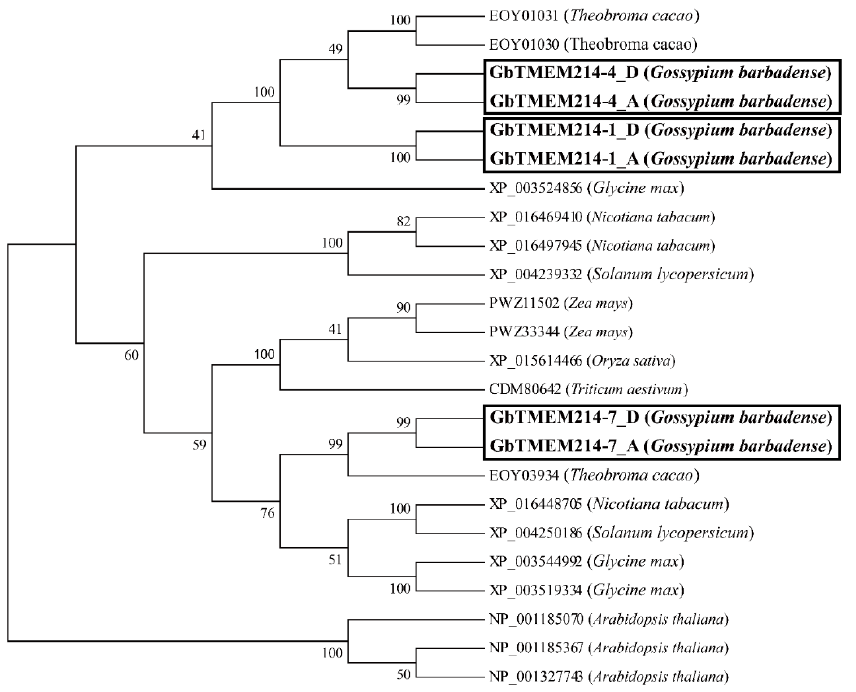
Figure 2. The phylogenetic trees of TMEM214 proteins in plants. MEGA 5.05 was applied to construct the phylogenetic trees of TMEM214 proteins. GbTMEM214s from G. barbadense were bolded and marked with a box.